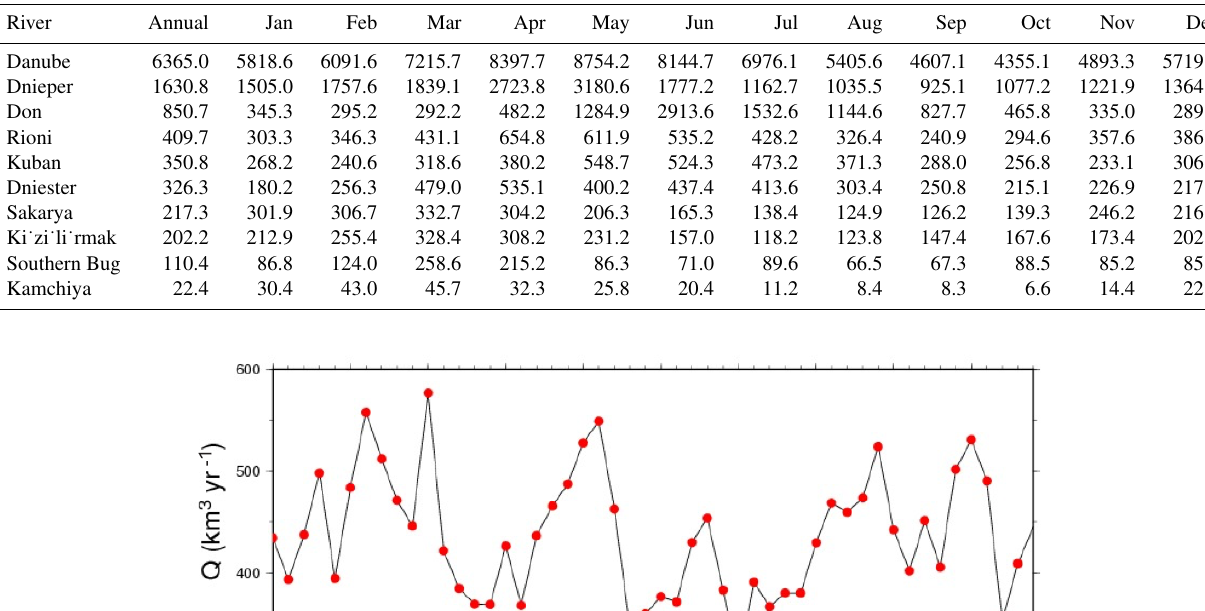
Table 1. Climatological monthly river runoff for major Black Sea rivers (m 3 s − 1 ).